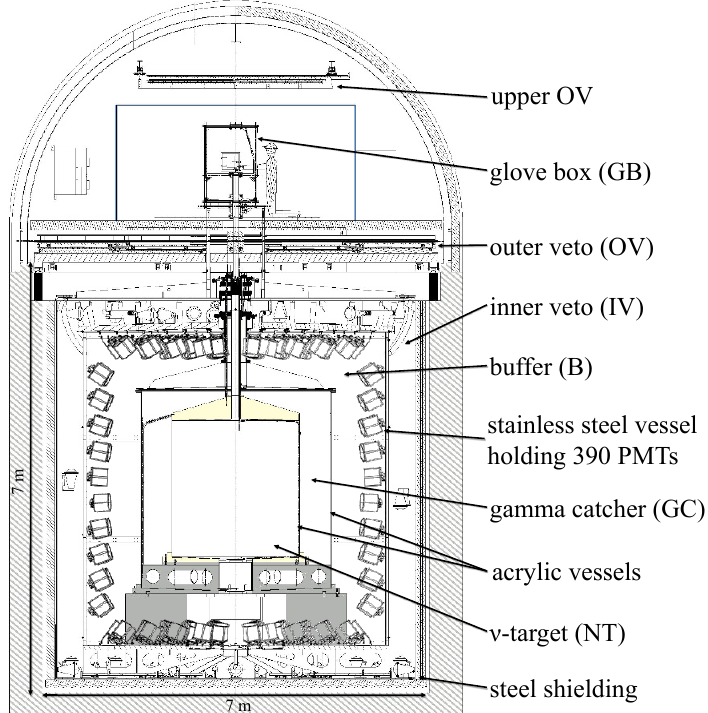
Figure 1 . Schematic of the Double Chooz